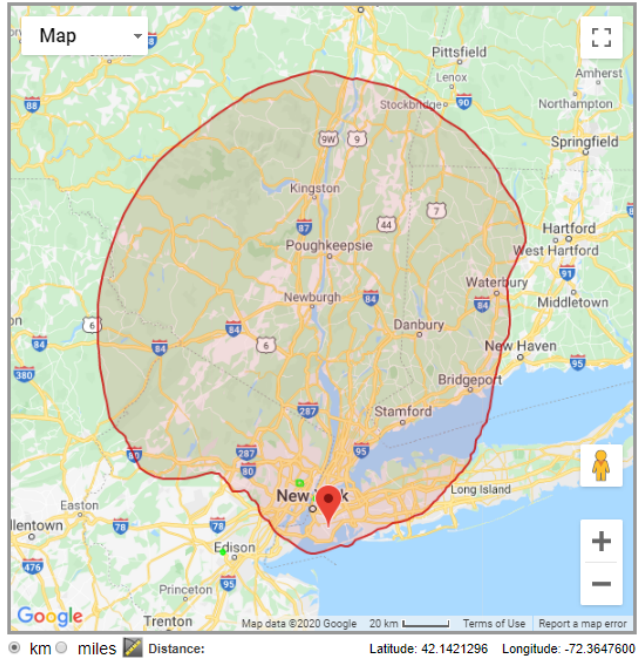
Figure 1. Exclusion zone for an available channel near New York city, US, as given by the LS Telcom database [29].